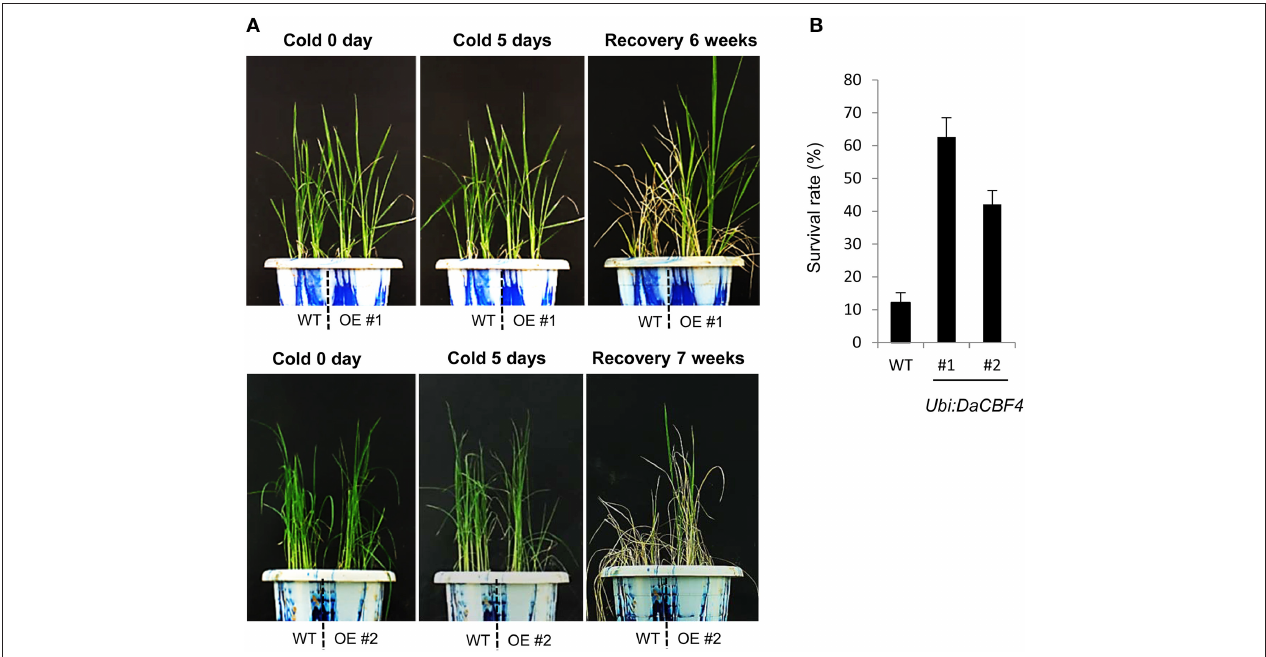
FIGURE 4 | Comparison of cold-stress tolerance between wild-type (WT) and Ubi:DaCBF4 transgenic plants. (A) Six-week-old wild type (WT) and T2 Ubi:DaCBF4 (line #1 and #2) rice plants were subjected to cold treatment at 4 ◦ C for 5 days, recovered to normal condition at 28 ◦ C, and then compared their survival rates. (B) Survival rates of WT and two independent transgenic lines under cold-stress conditions. Results are expressed as means from four independent experiments and 11 plants were used for each experiment. Error bars represents standard deviation of means of independent